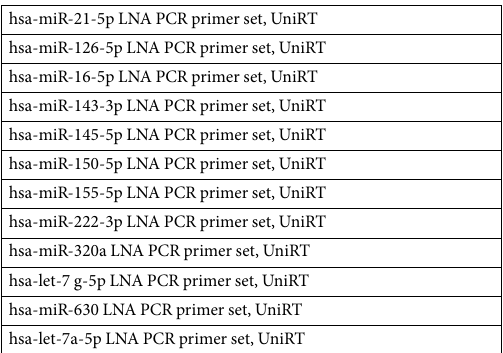
Table 2. miRNA set